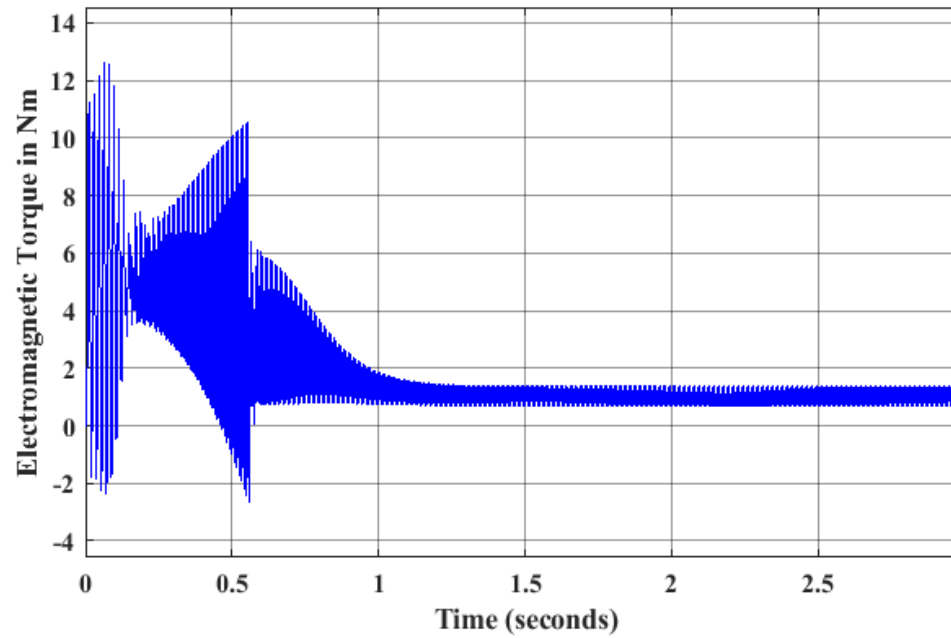
Figure 11. Electromagnetic torque of single stage SLMLI fed induction motor.